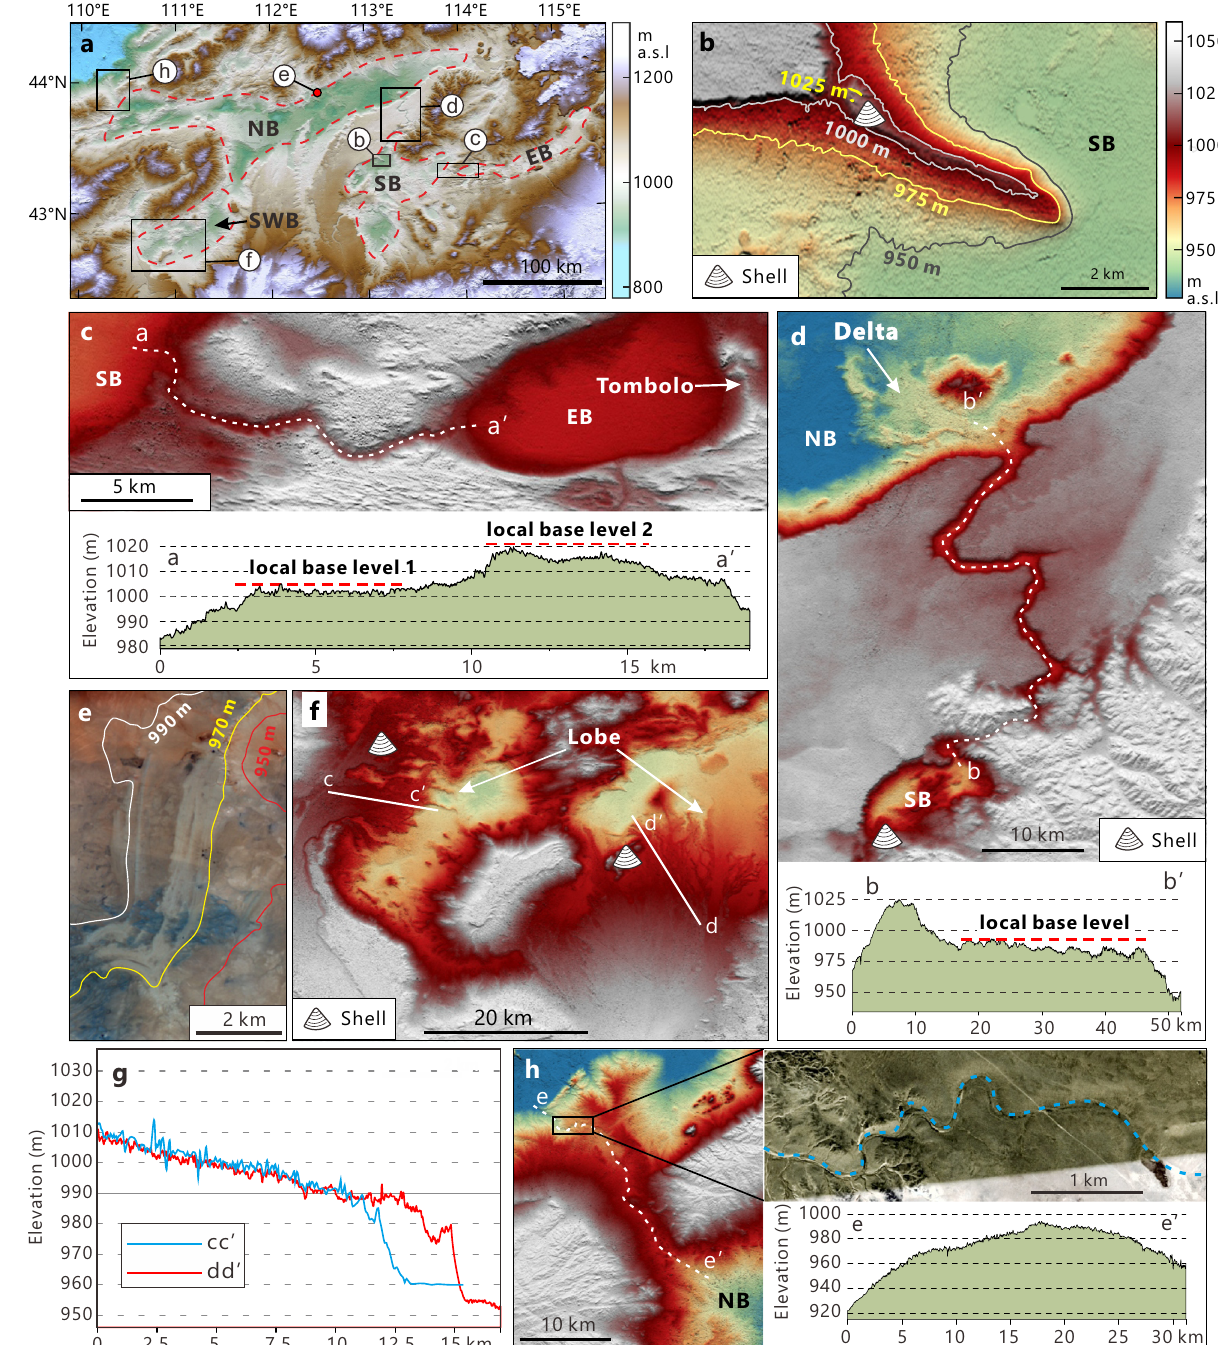
Fig. 2 | Elevation data illustrating geomorphic evidence of a paleolake system and drainage network of the East Gobi Desert. a Topography of the study area derived from the SRTM-3 DEM (digital elevation model, 90m resolution). The extents of four sub-basins, i.e. eastern basin (EB), southern basin (SB), northern basin(NB),andsouthwesternbasin(SWB)areindicated bydashed polygons.Black boxes delineate areas of higher resolution (ALOS World 3D 30m resolution) DEM datashowninpanels( b – d ),( f )and( h ). b Spitextendingfromthenorthshoreofthe SB. c DEM shows the paleochannel connecting the EB and SB. The longitudinal pro fi le of the channel (a-a ’ ) shows a stepped-bed morphology, implying the local